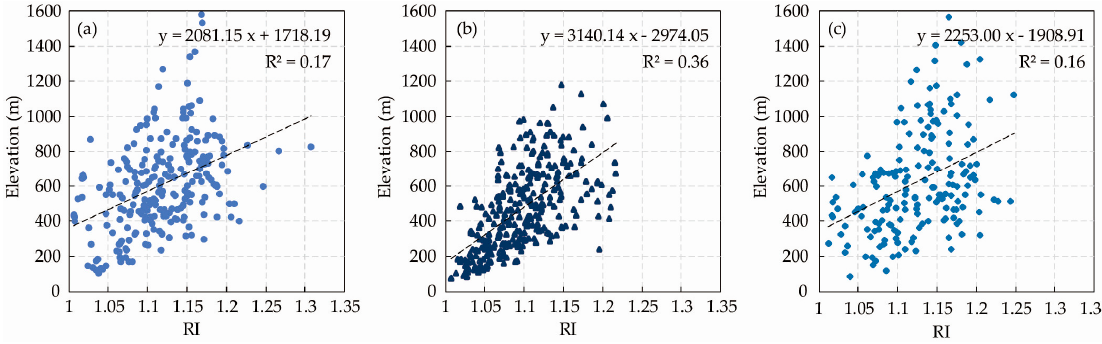
Figure 9. Scatter plot of the RI versus elevation values for the DFP types. ( a ) Water-flood; ( b ) Debris-flood; and, ( c ) Debris-flow.